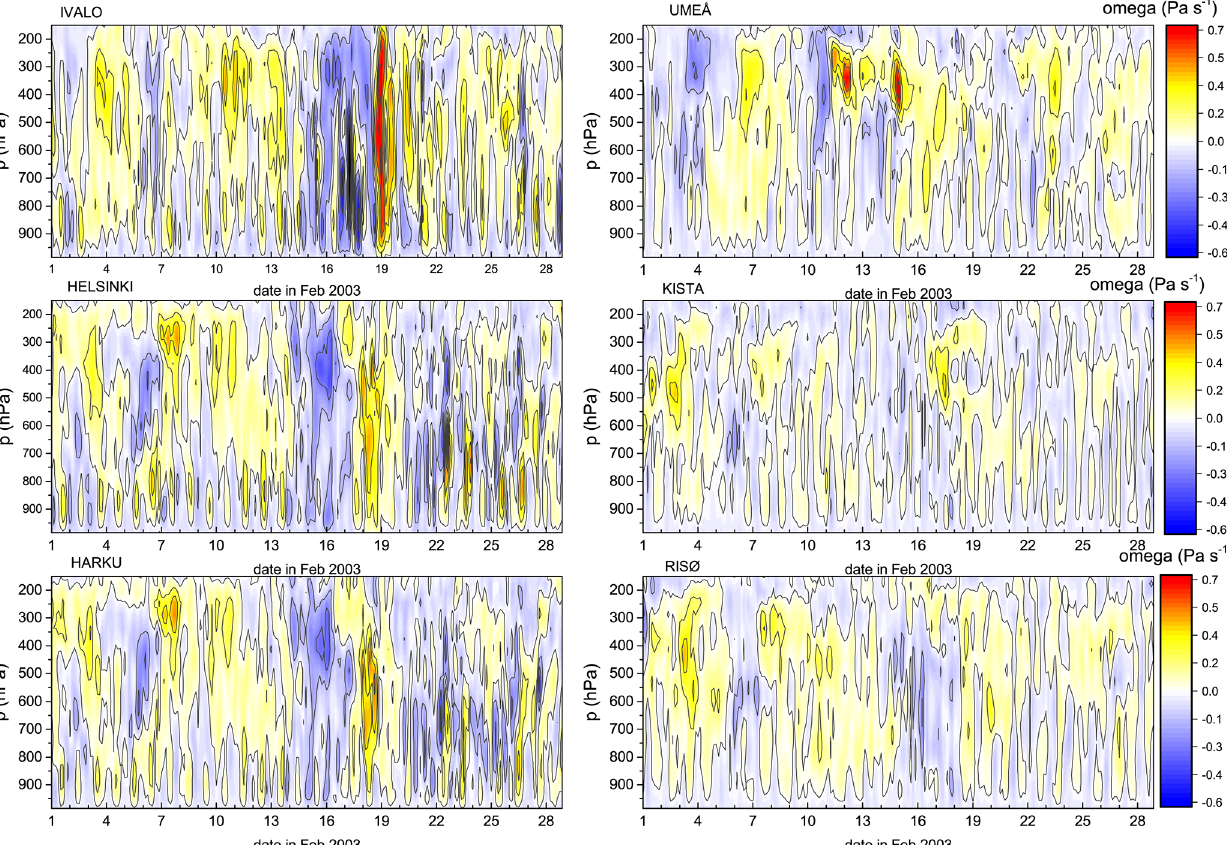
Figure 12. Time–height cross sections of MERRA-2 3-hourly average vertical pressure velocity (omega, in Pas − 1 ) during the month of February 2003 sampled at the six sampling sites. Red color indicates large positive omega values, corresponding to a descending motion, whereas blue color stands for large negative omega values, corresponding to a rising motion. Black lines are contours of omega